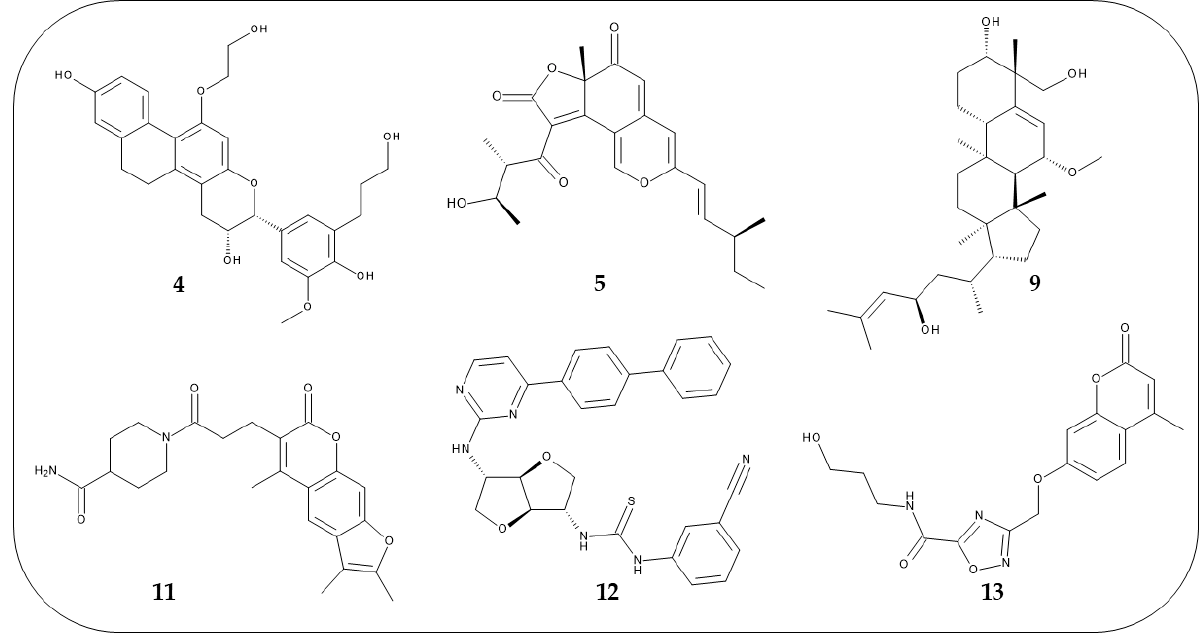
Figure 6. 2D structures of the six compounds selected from the docking studies.